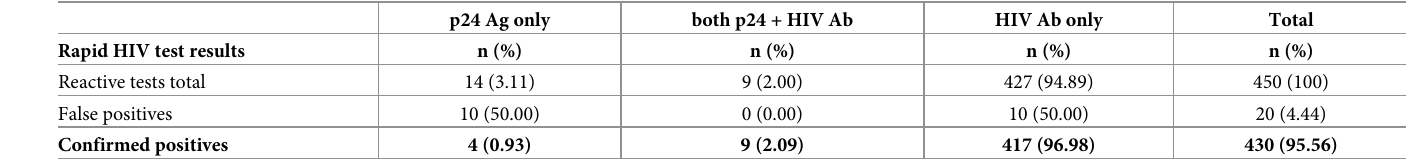
Table 2. Results of antigen and/or antibody rapid tests performed at BCN checkpoint, Spain (25 March 2016 to 24 March 2019).